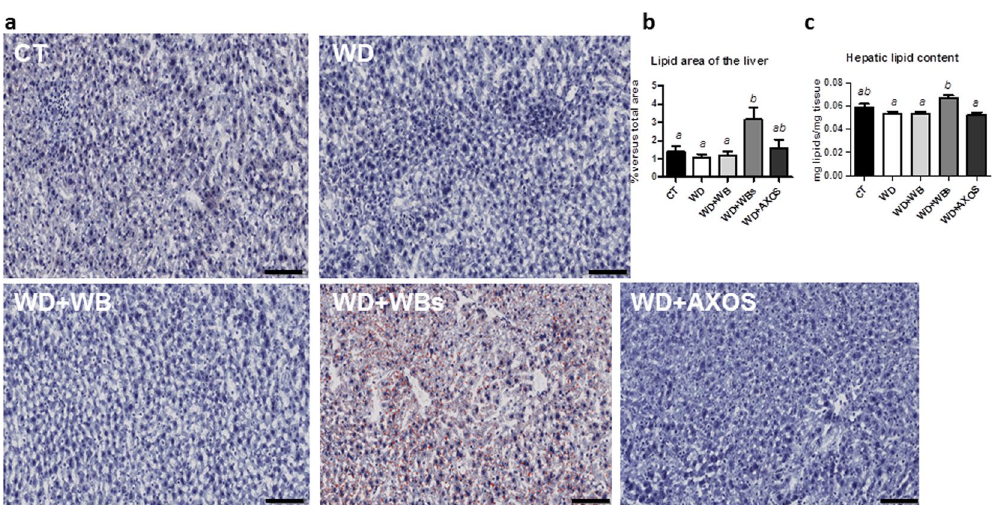
Figure 7. Impact of the three cereal fractions on lipid accumulation in the liver. Histochemical detection of neutral lipids of the liver sections ( a ), lipid area (% versus total area) ( b ) and lipid content of the liver ( c ) of mice fed a control diet (CT), a western diet (WD), a WD supplemented with 5% of wheat bran (WD + WB), a WD supplemented with 5% of wheat bran with reduced particle size (WD + WBs) or a WD supplemented with 5% of AXOS (WD + AXOS) for 8 weeks (scale bar = 100 μ m). Results are expressed as mean ± SEM (n = 7–9). Data with different superscript letters are significantly different at p < 0.05